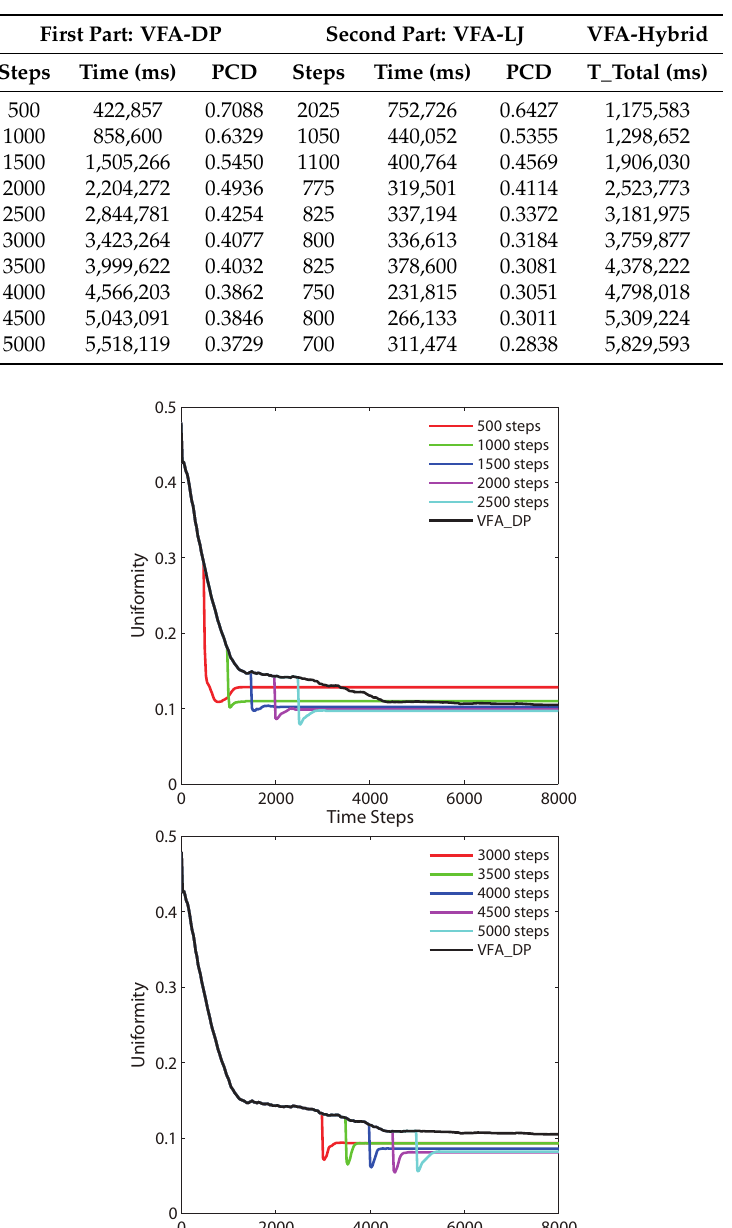
Table 2. Algorithm runtime and PCD values calculated from two parts of VFA-Hybrid algorithm for the specified time steps corresponding to Figure 4.